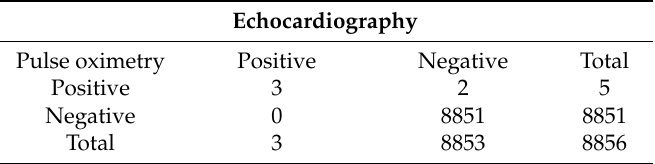
Table 1. Screening for congenital cardiac heart defects: analysis of results.